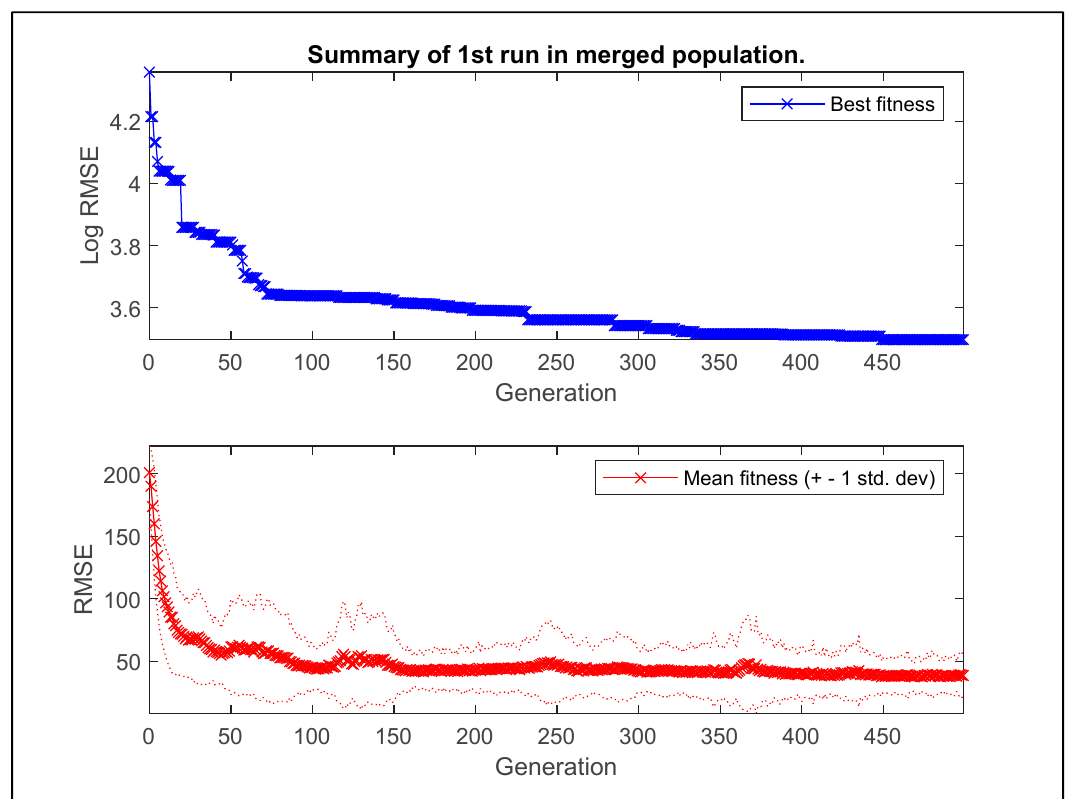
Figure 8. Example of a run summary shows reduction in RMSE with the number of generations.